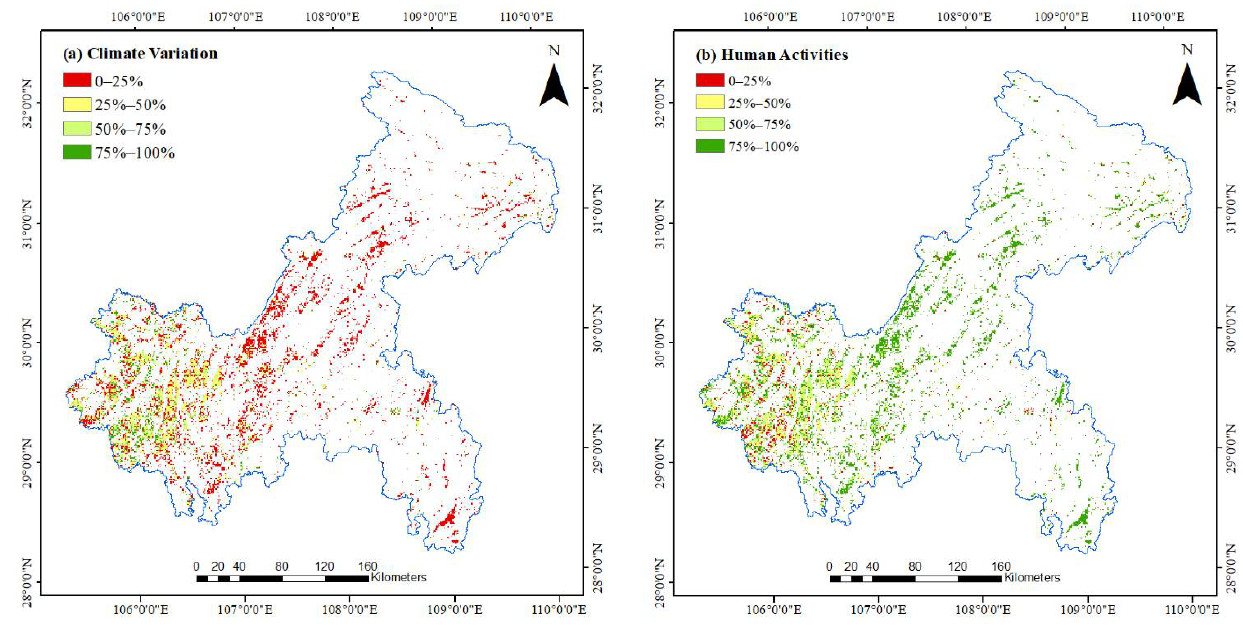
Figure 9. Relative contribution of ( a ) climate change and ( b ) human activities on areas of decreased vegetation cover.